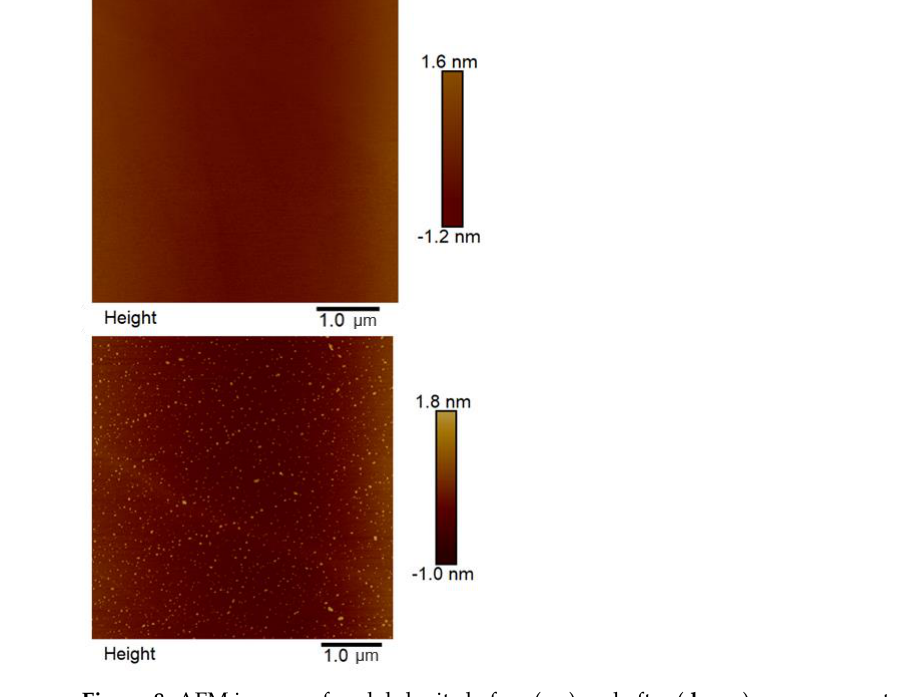
Figure 8. AFM images of molybdenite before (up) and after (down) carrageenan treatment.